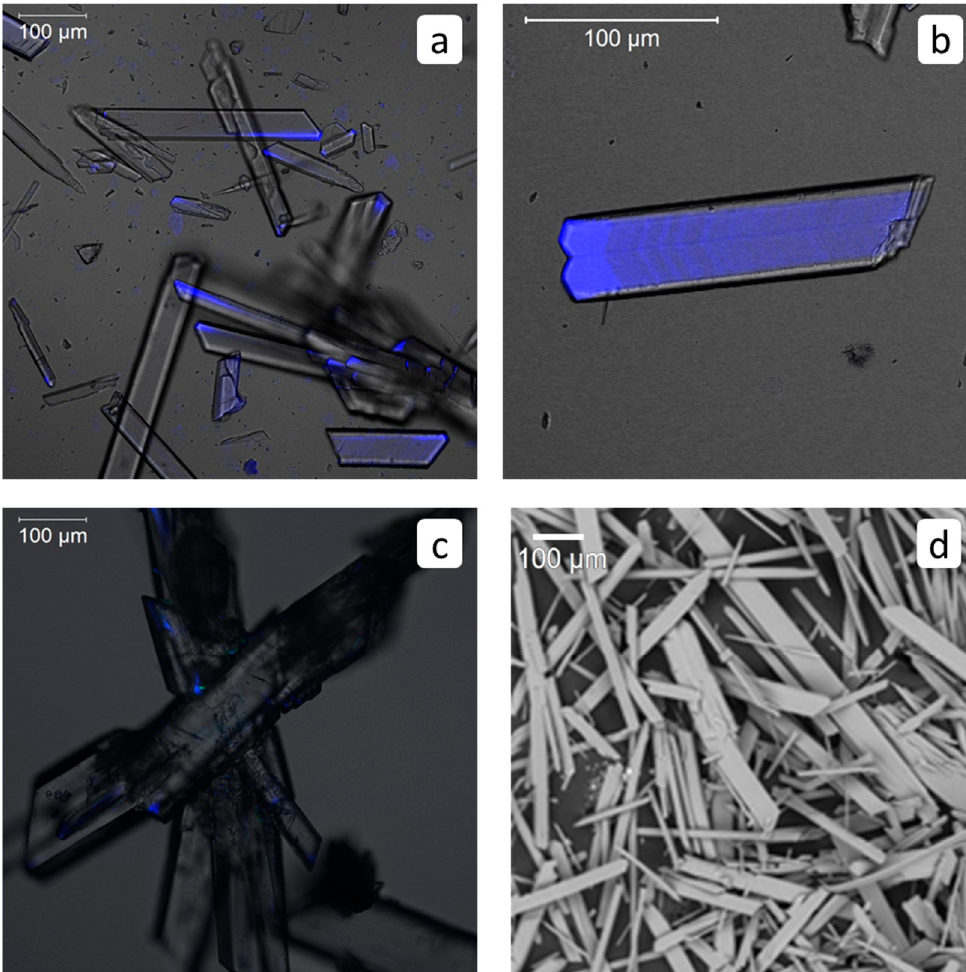
Figure 6. Fluorescent images of the liquid phase of a gypsum solution with 10 mg·dm − 3 HEDP-F after 24 h thermal treatment by the NACE Standard ( a – c ) and SEM image of CaSO 4 ·2H 2 O crystals, isolated within the blank experiment in the absence of antiscalant ( d ). Scale marker corresponds to 100 µm.